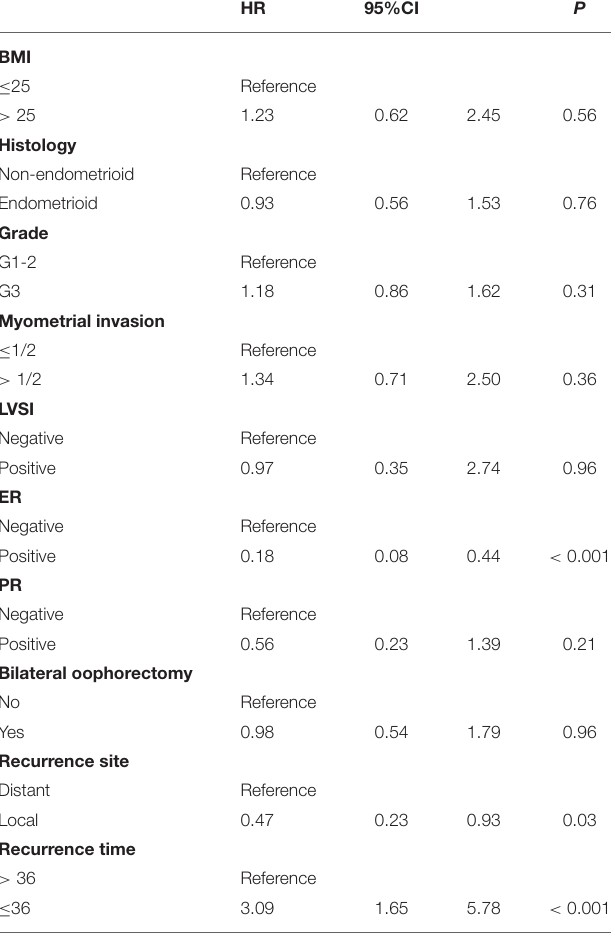
TABLE 2 | Univariate analysis on post-relapse overall survival time. TABLE 3 | Multivariate Fine-Gray competing risk regression analysis on postrelapse overall survival